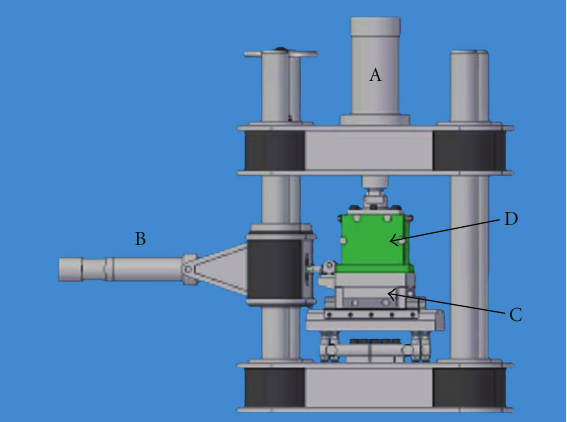
Figure 1: Schematic drawing of the testing machine. (A) Vertical jack for application of the compressive load; (B) horizontal jack for application of sliding movement; (C) sledge supported by roller bearings; (D) thermal chamber. The specimen (not visible) supported by the sledge (C) is enclosed in the thermal chamber (D) during the